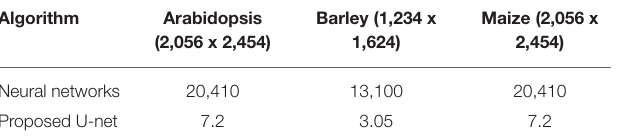
Frontiers in Plant Science |